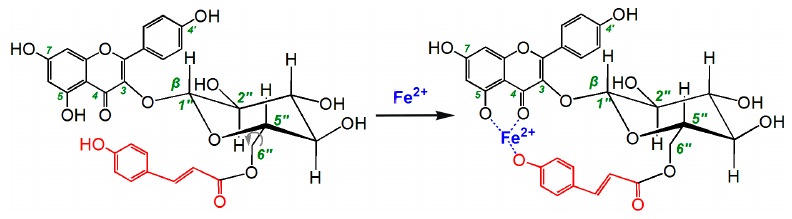
Figure 5. Proposed reaction of tiliroside chelating Fe 2+ .